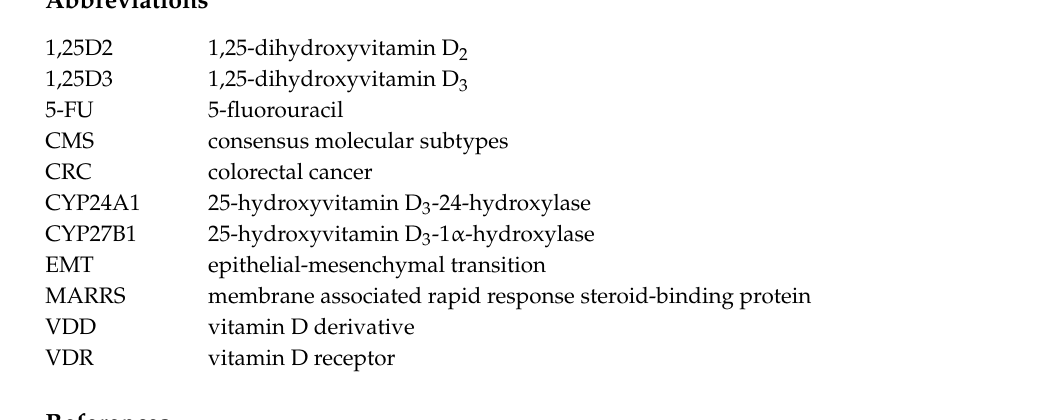
Figure S1: HPLC profiles of VDDs, PRI-5105 and PRI-5106, before and after incubation with h CYP24A1 Figure S2: Chemical structures of VDDs of 1,25D2, Figure S3: The ratio of the EMT markers (E- to N-cadherin) and the enzymes that catalyze the hydroxylation of vitamin D metabolites into its active or inactive form (CYP27B1 to CYP24A1, respectively) in HT-29 and HCT116 CRC cell